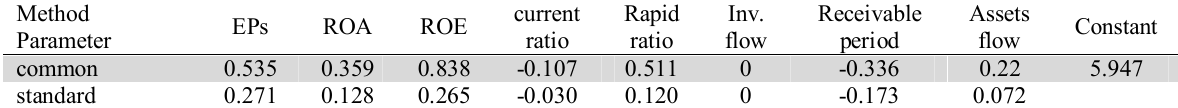
The summary of multi-variables linear-regression